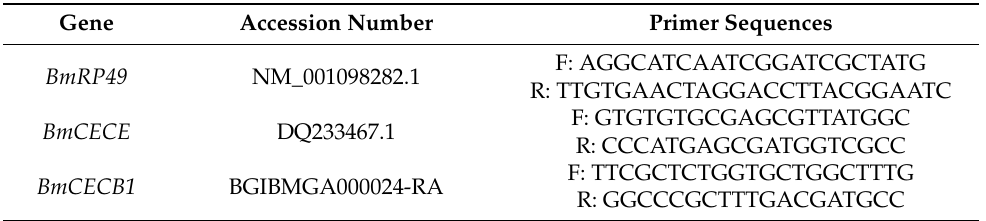
Table 2. Primer sequences used in this